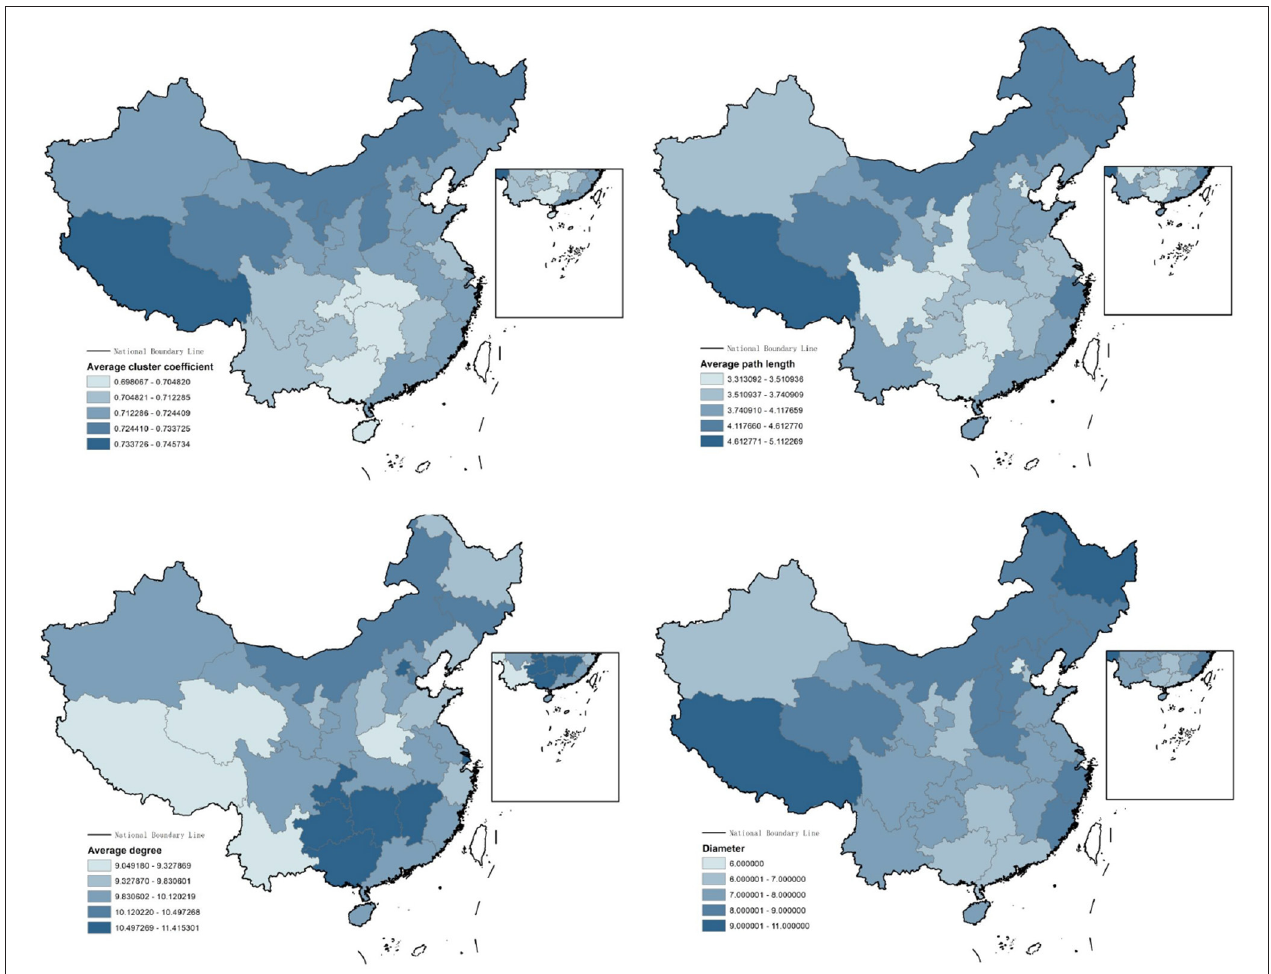
FIGURE 4 | Network characteristics of 30 provinces analyzed through the visibility